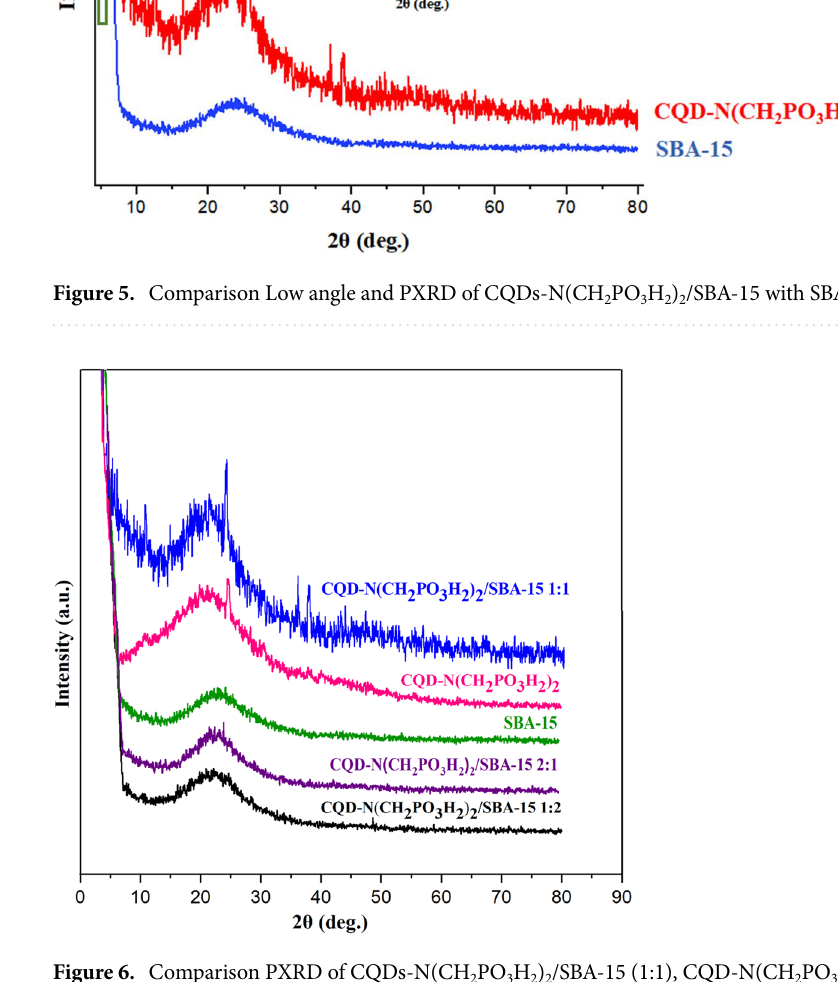
Figure 6. Comparison PXRD of CQDs-N(CH 2 PO 3 H 2 ) 2 /SBA-15 (1:1), CQD-N(CH 2 PO 3 H 2 ) 2 , SBA-15, CQDs- N(CH 2 PO 3 H 2 ) 2 /SBA-15 (2:1) and CQDs-N(CH 2 PO 3 H 2 ) 2 /SBA-15